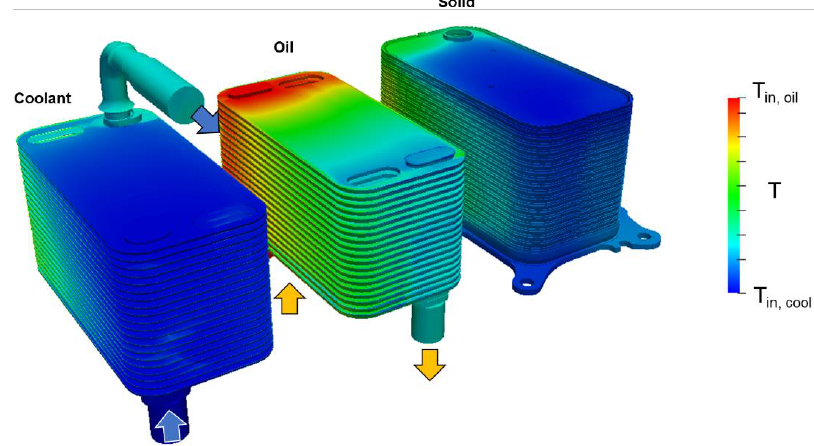
Figure 18. Cooler B: Temperature field on solid, oil and coolant regions. Operating conditions: Q oil = 50%, Q cool = 80%.